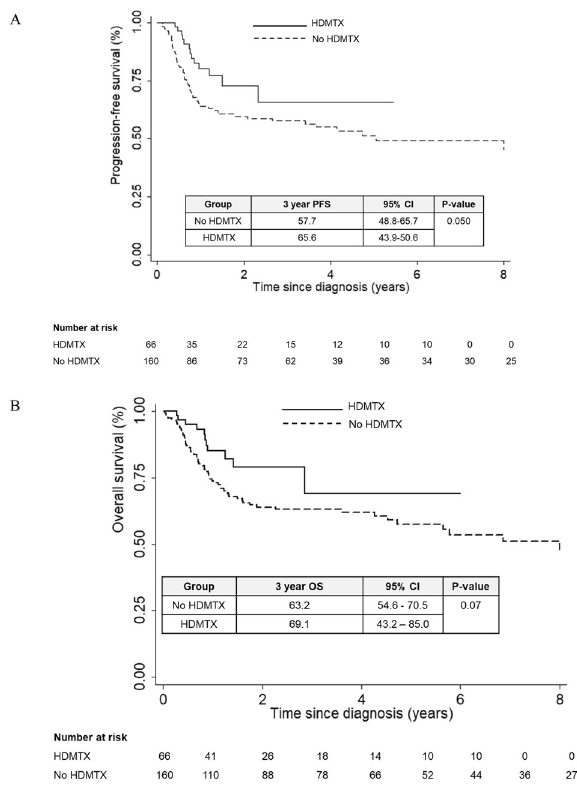
Fig. 2 Survival outcomes in the overall patient population. A Progression Free Survival by HDMTX prophylaxis. B Overall Survival by HDMTX prophylaxis. HDMTX, high dose